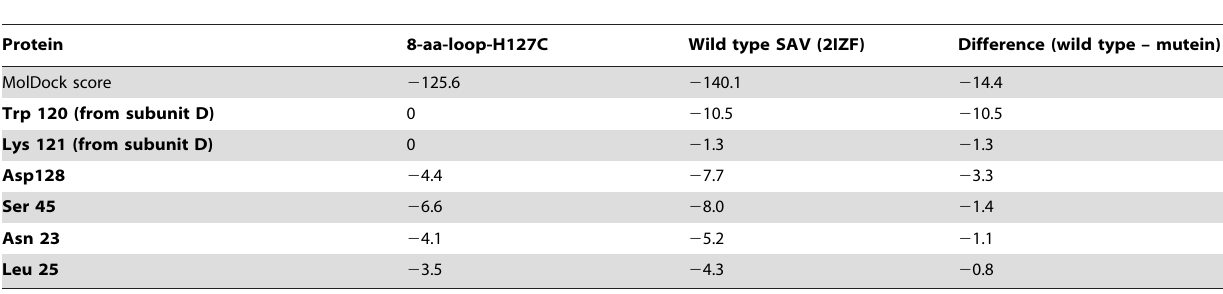
Table 3. Interaction of biotin with residues in the biotin binding pocket of subunit A.